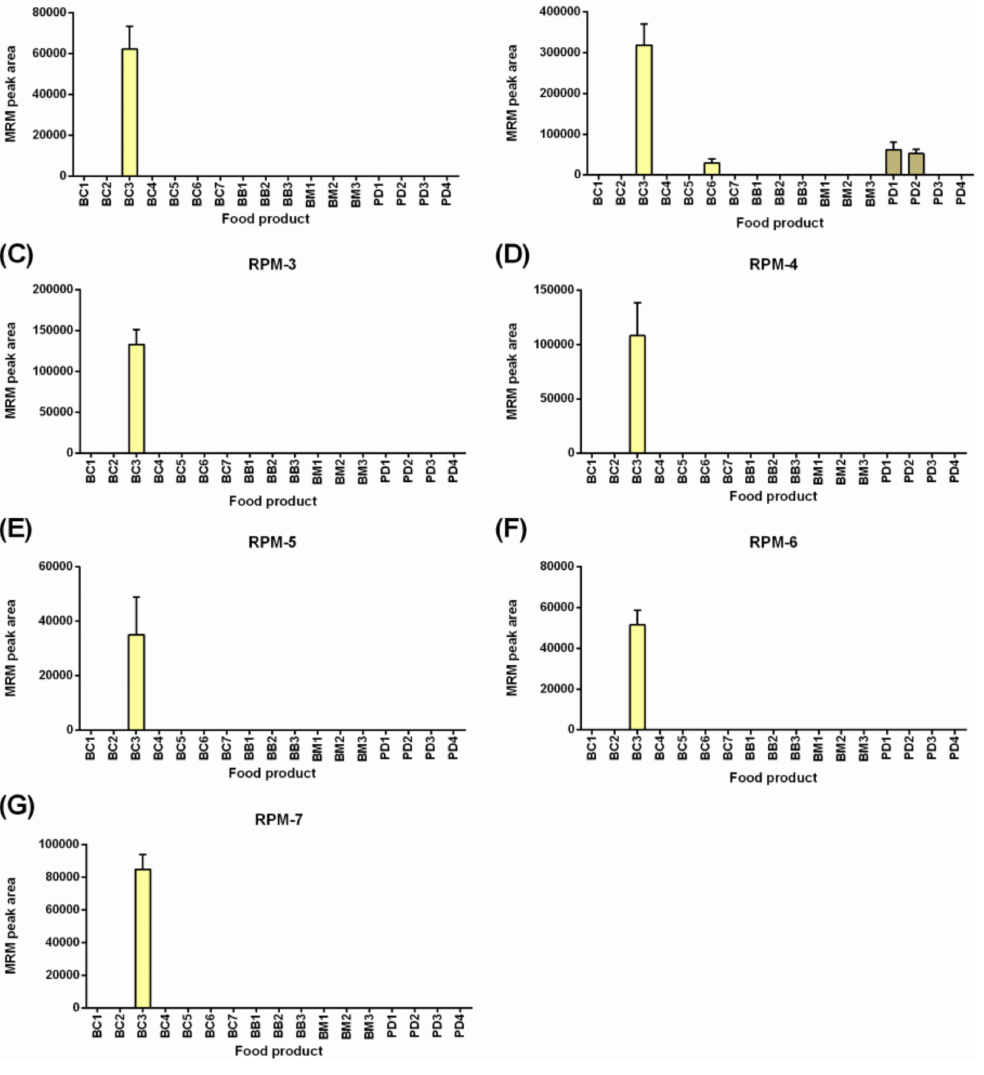
Figure 3. LC-MRM-MS analysis of seven rye peptide markers (RPMs) across a range of commercial Australian breakfast food products. The peak area + SD is plotted ( n = 4). Panels ( A ) through ( G ) refer to the ten RPMs defined in Table